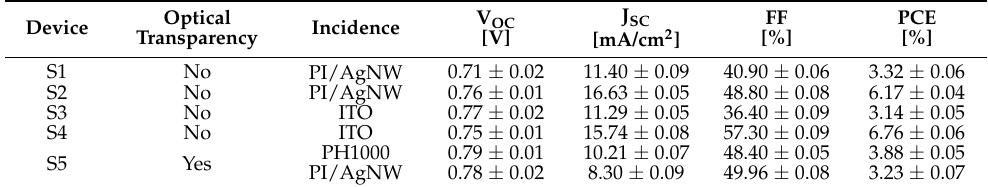
Figure 4. ( a ) J – V curves of the S5 device illuminated from the PH1000 and the PI/AgNW, respectively. The inset in the figure is the schematic diagram of the structure of semitransparent flexible OSCs (S5) with PI/AgNW TCEs as the cathode. ( b ) Transmittance curve. The inset in the figure is an actual photo of the all ‐ flexible semitransparent device S5. ( c ) Calculated absorbed power curve as well as ( d ) extracted charges vs light intensity curve for the all ‐ flexible semitransparent device illuminated from the PH1000 and the PI/AgNW, respectively. Table 1. Statistical V OC , J SC , FF, and PCE of flexible and semitransparent devices under the illumination of AM1.5G (100 mW/cm 2 ).